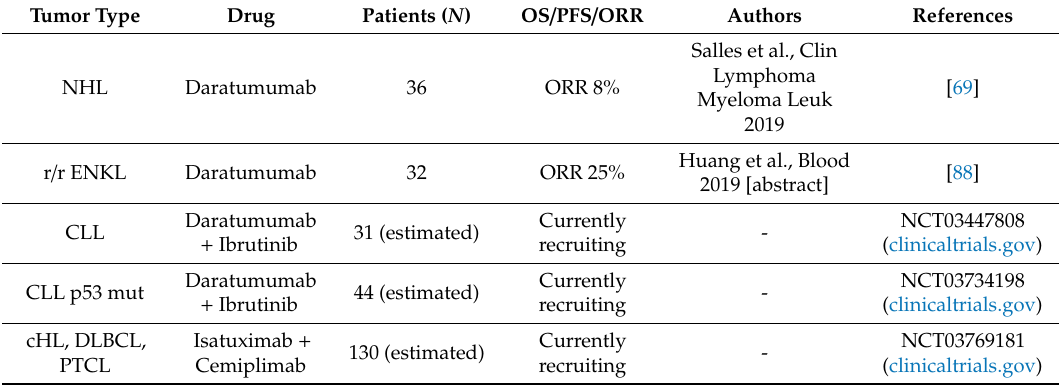
Table 1 summarizes currently available results and ongoing phase I / II clinical trials on the e ffi cacy of anti-CD38 antibodies as monotherapy or combination therapy in lymphoid malignancies. Table 1. E ffi cacy of anti-CD38 antibodies for the treatment of lymphoproliferative neoplasms, current data, and future